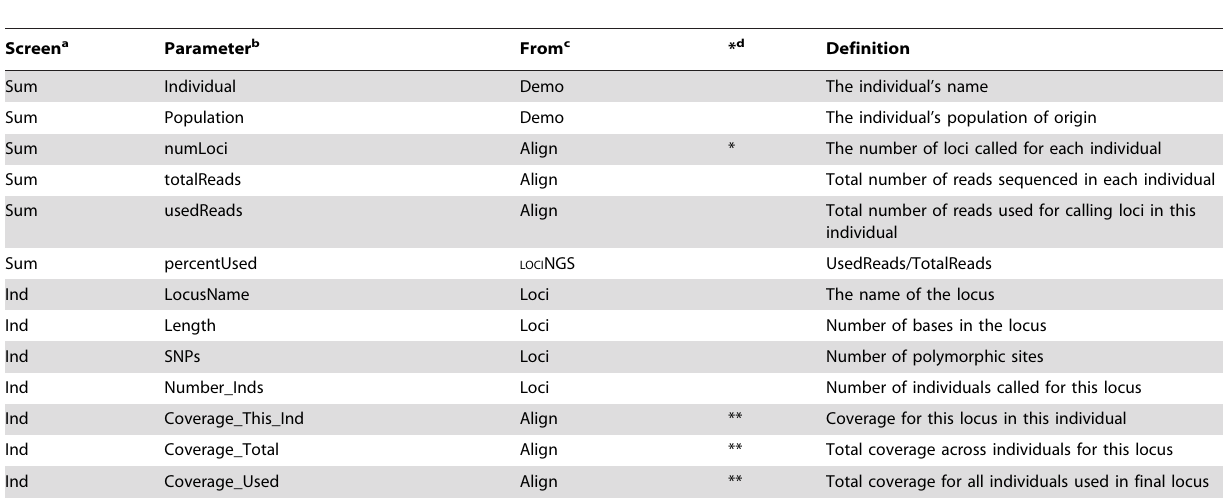
Table 1. LOCI NGS parameters for the summary screen (Sum; Fig. 1a) and the individual screen (Ind; Fig. 1b).